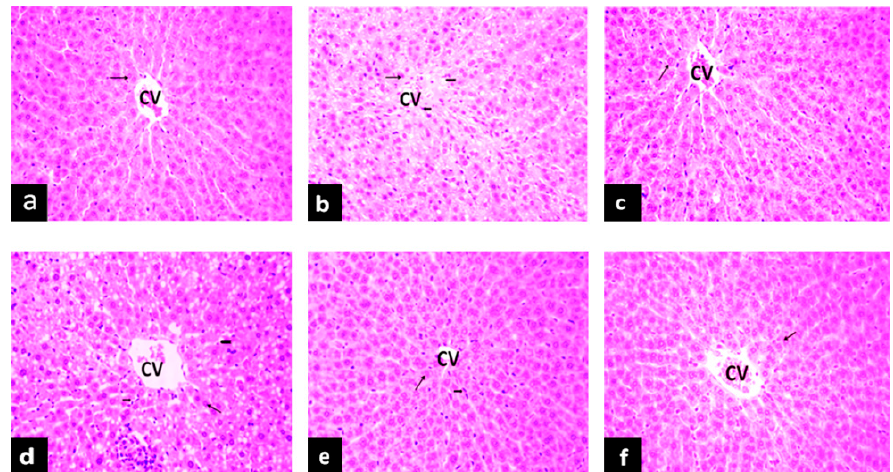
Figure 4. The effects of purified anthraquinone-Glycoside from Rheum palmatum L. (PAGR) on histopathological changes in the liver of rats. Histological observation, H&E, a–f×200; ( a ), normal (NC) group; ( b ), type 2 diabetes mellitus (T2DM) group; ( c ), metformin (Met) group; ( d ), Low group;